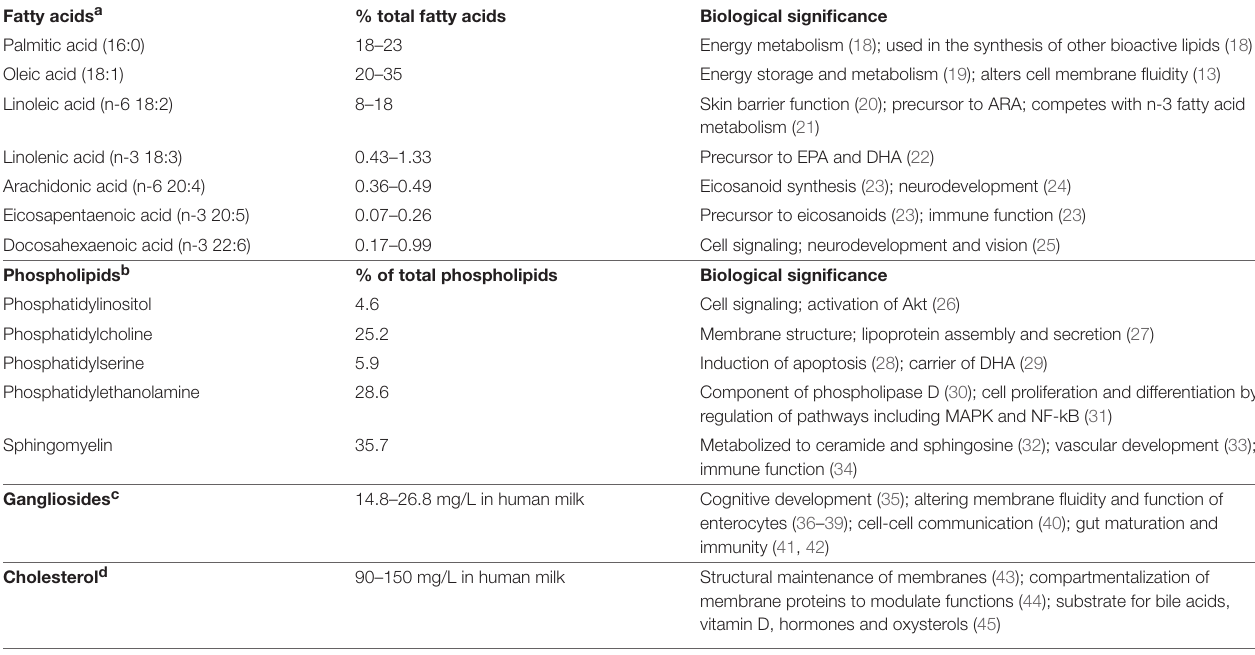
TABLE 1 | Lipid composition in milk fat